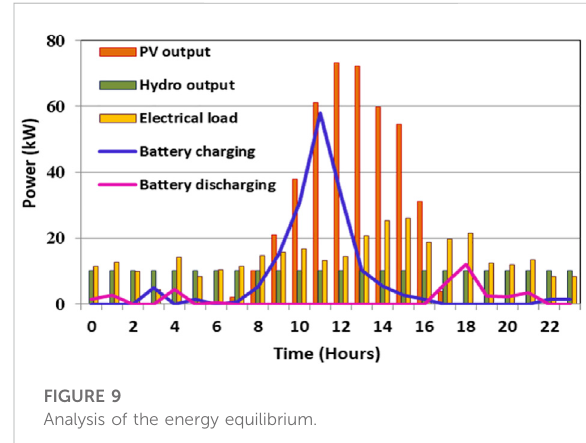
FIGURE 9 Analysis of the energy equilibrium.